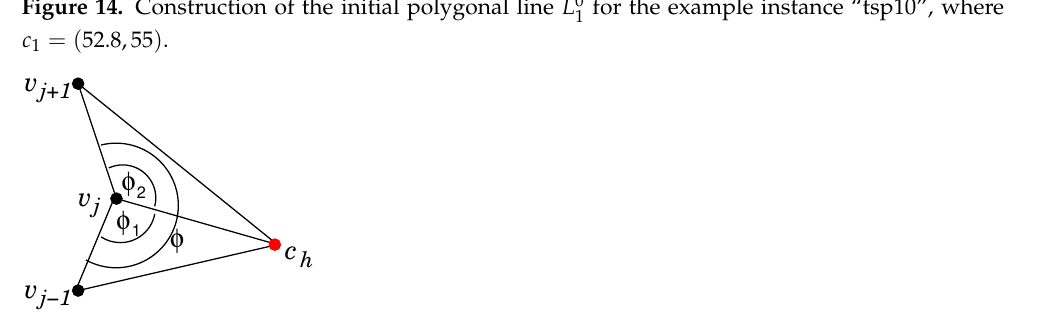
Figure 15. Angle φ ( v j − 1 , v j , v j + 1 , c h ) formed by the edges ( v j − 1 , v l ) and ( v j , v j + 1 ) , where v j − 1 , v j , and v j + 1 are consecutive vertices from polygonal line L l − 1